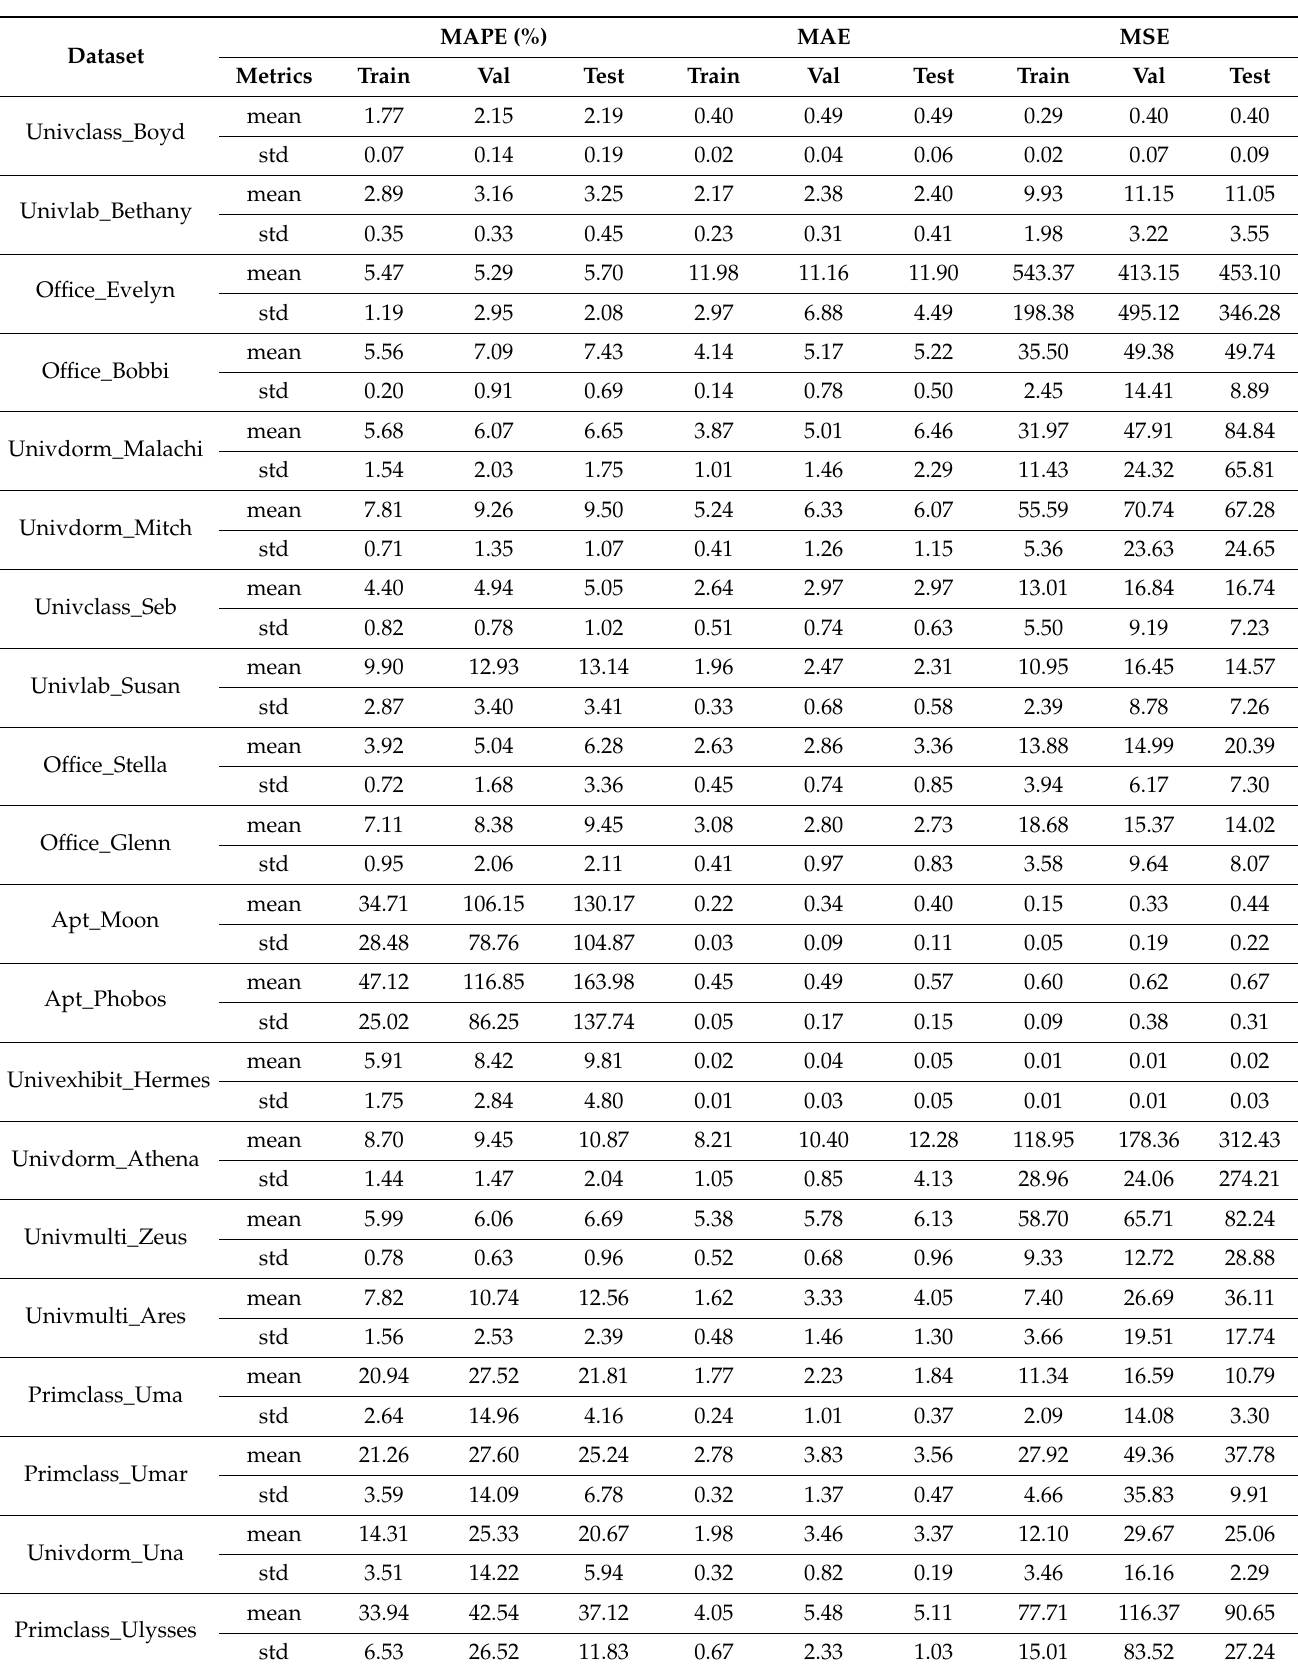
Table 13. The cross-validation result of forecasting using RNN without